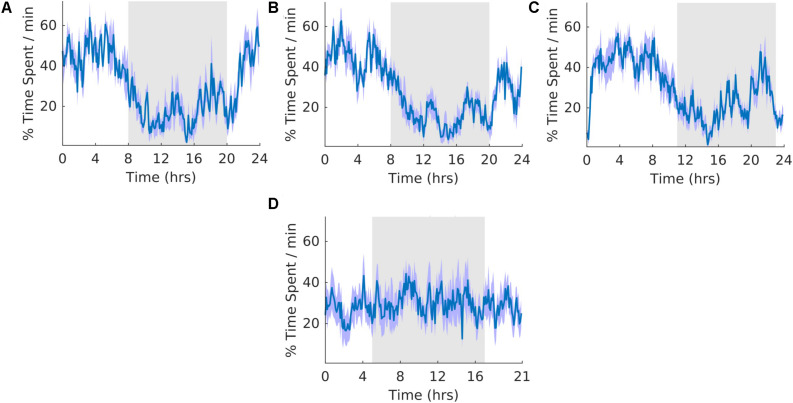
Motionless sleep. (A) Group average normalized waveforms for the 6 days pre-T21 stage of the experiment. (B) Group average normalized waveforms for the 6 days T21 stage of the experiment. (C) Group average normalized waveforms for the 6 days post-T21 stage of the experiment. (D) Group average normalized waveforms for the 6 days T21 stage of the experiment framed for a period of 21 h. The gray shaded area represents lights off, and the purple shaded area represents standard error of the mean.